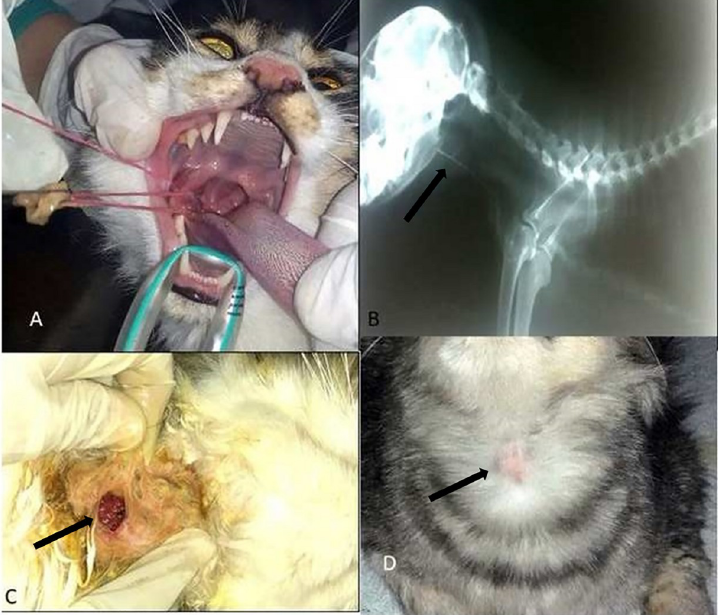
Fig 2. Complications of foreign bodies in the area of the oesophageal entrance (cervical region of the oesophagus caudal to pharynx). a. Photographic picture showing passing of needle and attached thread in epiglottis. b. Lateral radiographic view of cat showing radiopaque needle barrelled to oesophagus (black arrow). c. Photographic picture showing needle (black arrow) passing through oesophageal wall and forming abscess. d. Photographic picture showing small abscess at the level of the cervical oesophagus (black